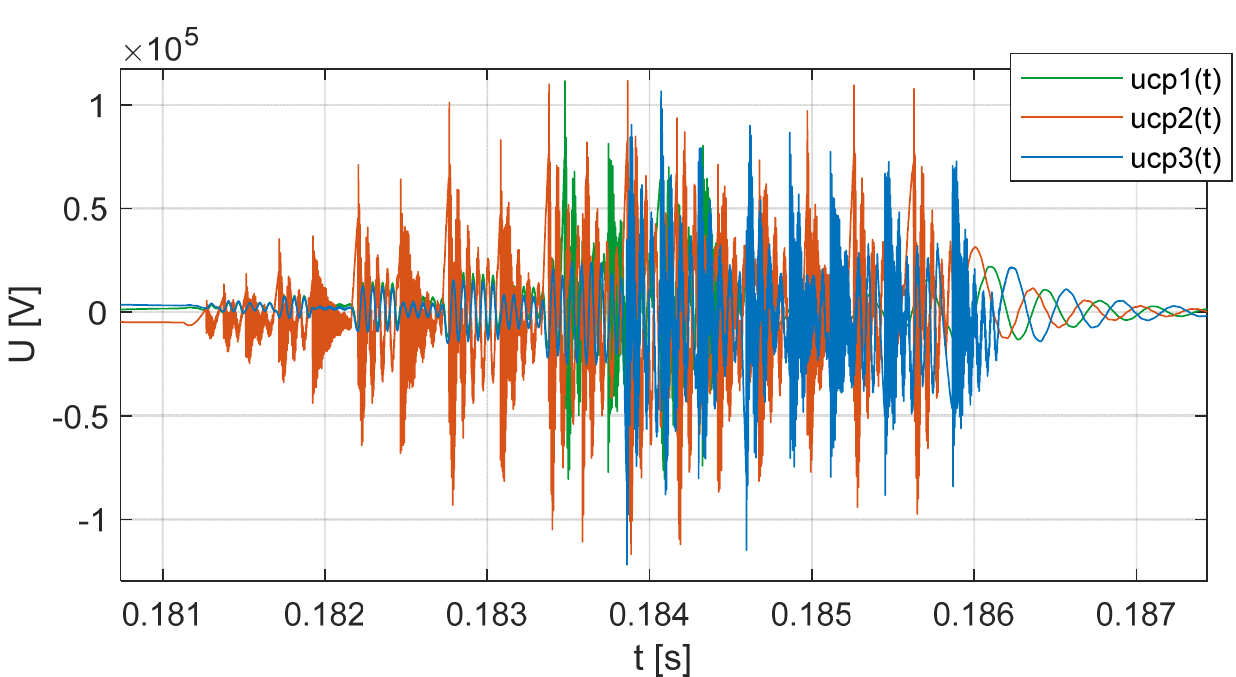
(𝑡) (EMTP algorithm). Source: own calculations. Figure 20. Simulation results—Load voltage 𝑢 ( t ) (EMTP algorithm). Source: own Figure 20. Simulation results—Load voltage u C (cid:3004) (cid:3265) P